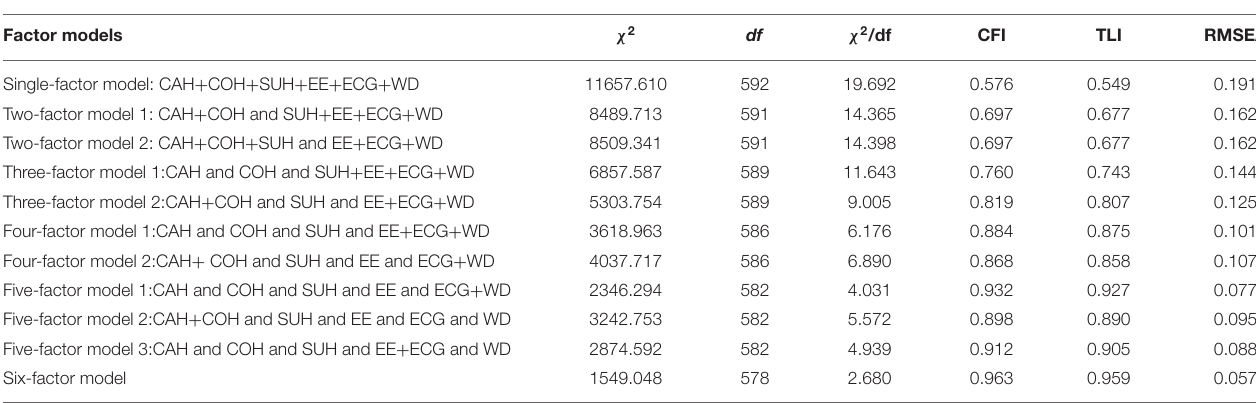
TABLE 2 | Results of the confirmatory factor analysis for the main